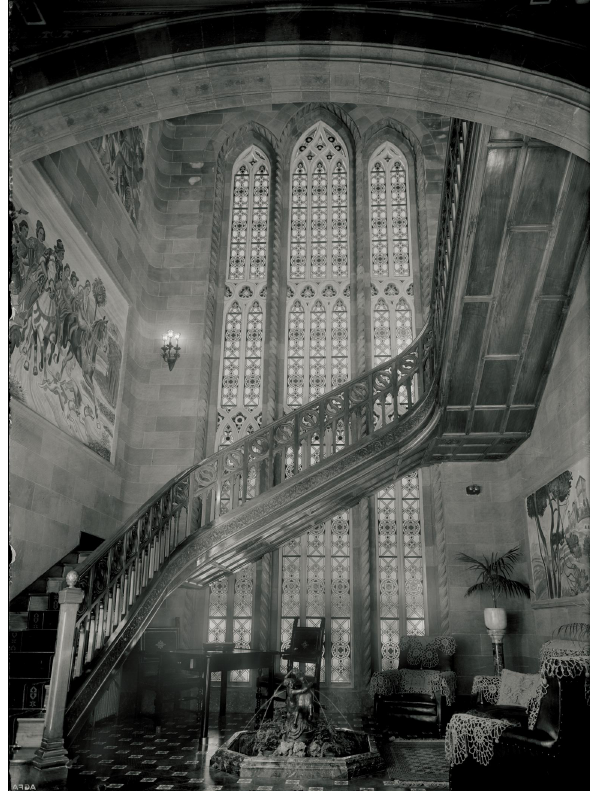
Figure 8 . Interior details of Villa Rutelli.